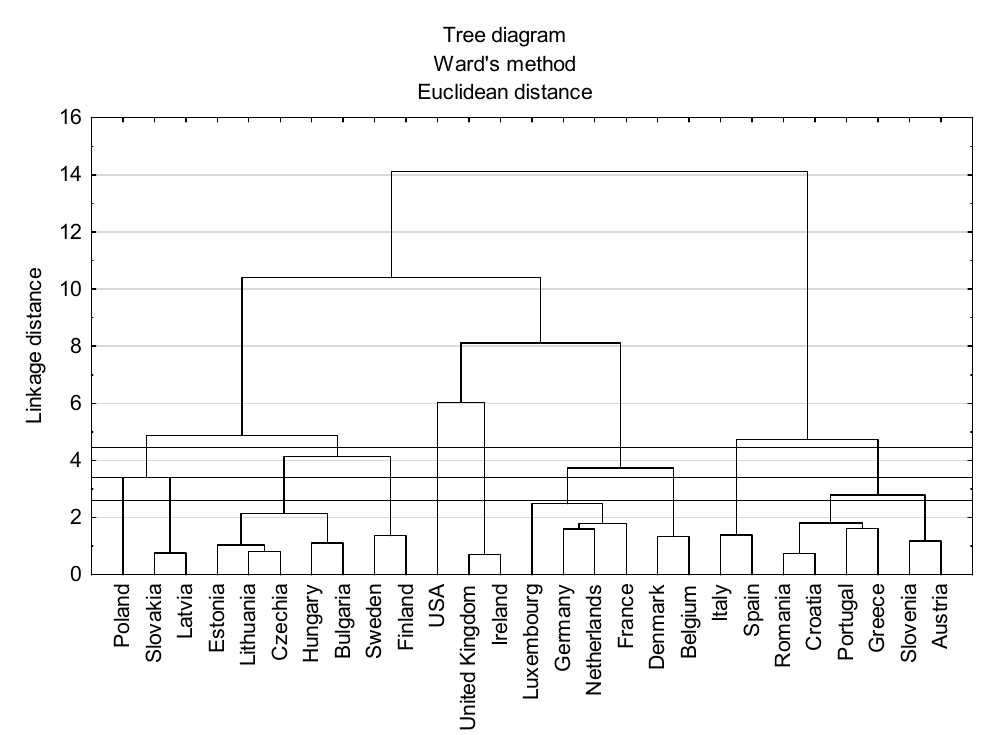
Figure 1. The course of agglomeration in the EU countries and the USA depending on the produc- tion potential of the agricultural sector. Source: The authors’ calculations based on [58–63].